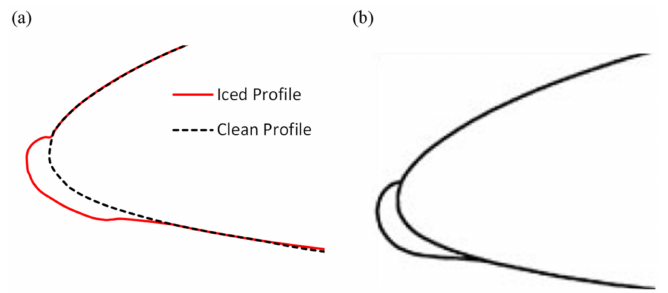
Figure 8. ( a ) Leading edge detail resulting from this study, ( b ) ice shape from